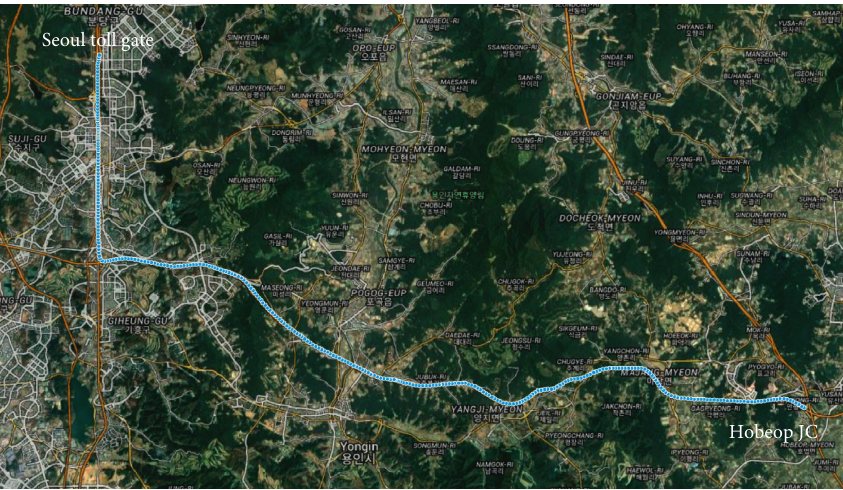
Figure 10: Route of the vehicle collecting the database. Table 2: Summary of experimental DB.